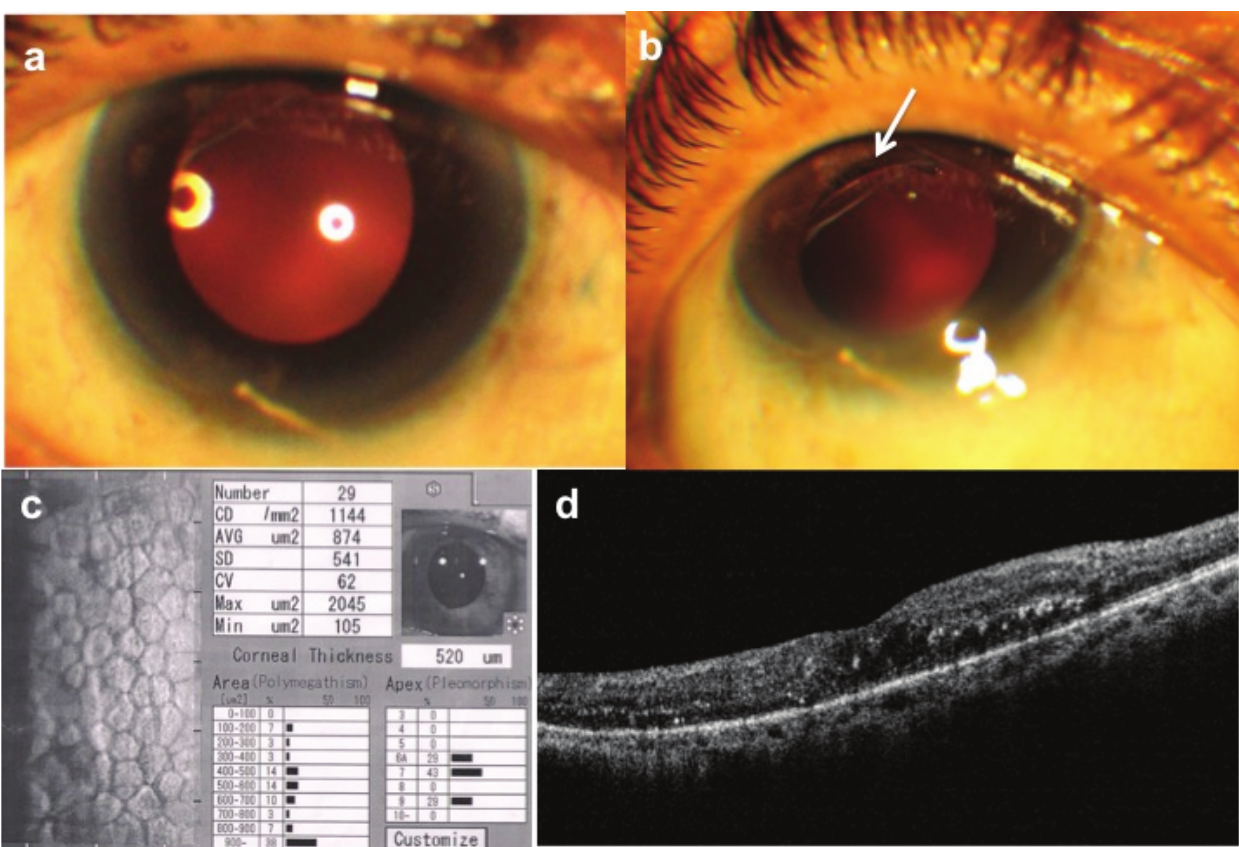
Figure 1. (a) Clinical photograph of the right eye showing a clear cornea, scleral-fixated posterior chamber intraocular lens (SFIOL) in situ, and an intravitreally administered dexamethasone (DEX) implant lying inferiorly in the anterior chamber. (b) A gap between the IOL edge and pupil margin could be seen in upgaze (white arrow). (c) Endothelial count of the right eye performed on the same day. (d) Spectral domain optical coherence tomography (SD-OCT) showing mild macular edema and hard